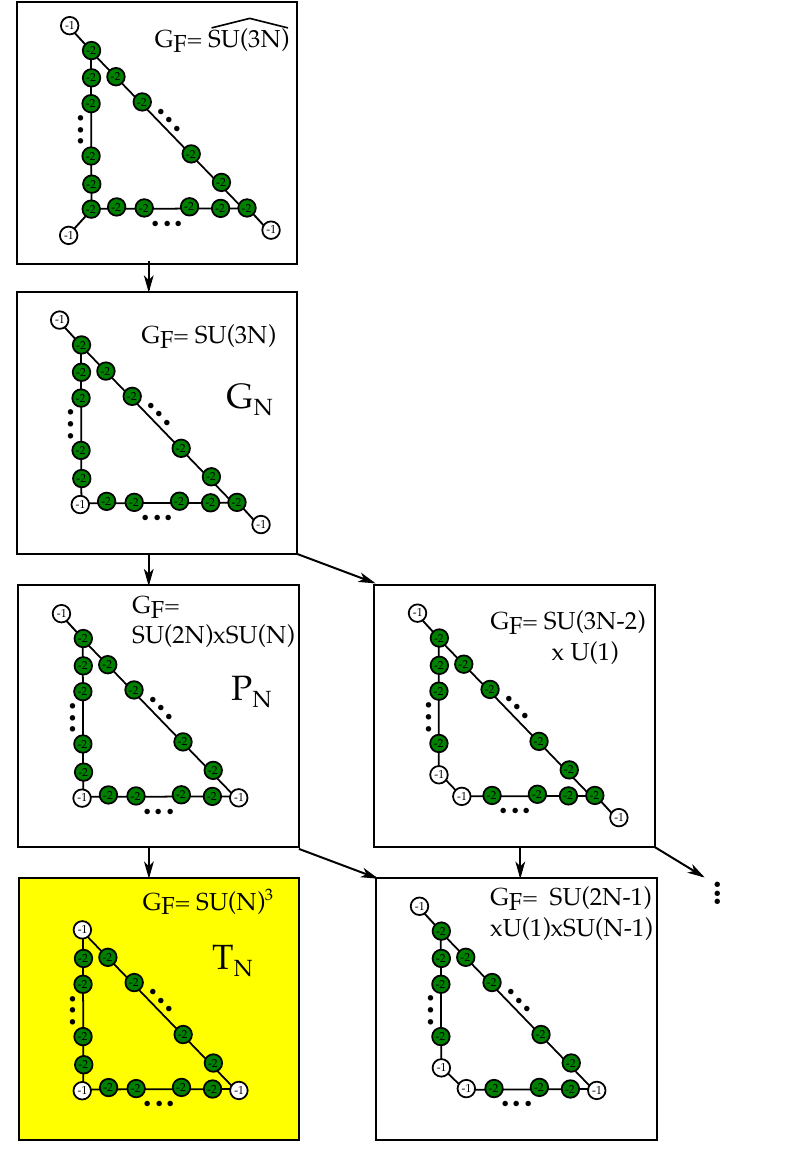
Figure 15 . Geneaological tree of T N : the theory at the top is the KK-theory, obtained from 6d by circle reduction. The (cid:12)rst mass deformation (up to permutation) is the 5d SCFT G N , with (cid:13)avor symmetry G F = SU(3 N ). It has two descendants, with one of them the theory P N with G F = SU(2 N ) (cid:2) SU( N ). Further mass deformation yields T N . Hence the spin-0 hypermultiplet is given by a P 1 curve with normal bundle N = O ( (cid:0) 1) (cid:8) O ( (cid:0) 1), and a spin-1 vector multiplet is given by a P 1 curve with normal bundle N = O (0) (cid:8) O ( (cid:0)